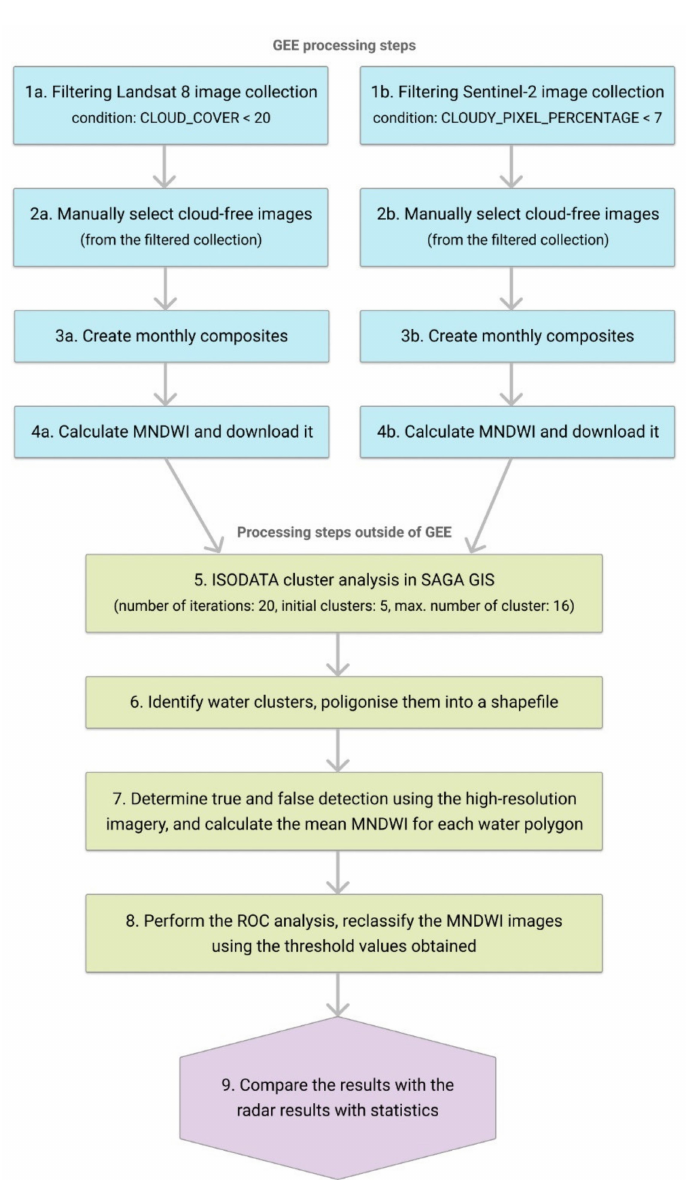
Figure 4. Flowchart of the data processing steps applied to the Landsat 8 OLI and Sentinel-2 MSI